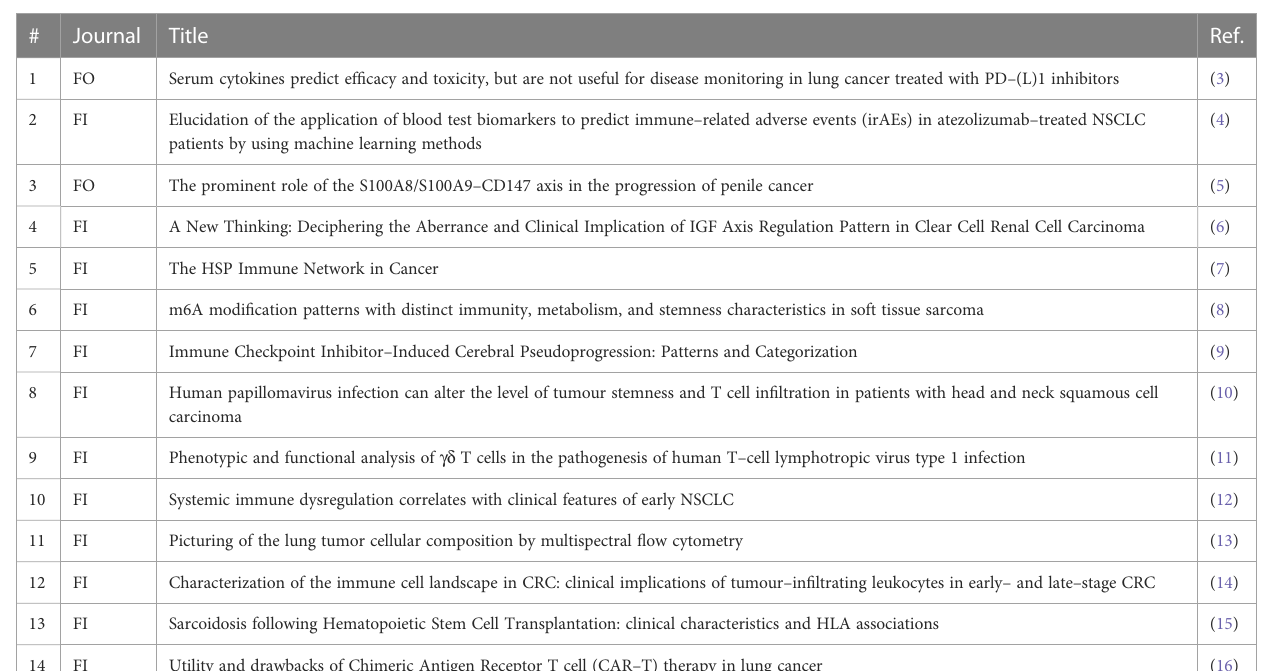
TABLE 1 Articles published as part of the current research